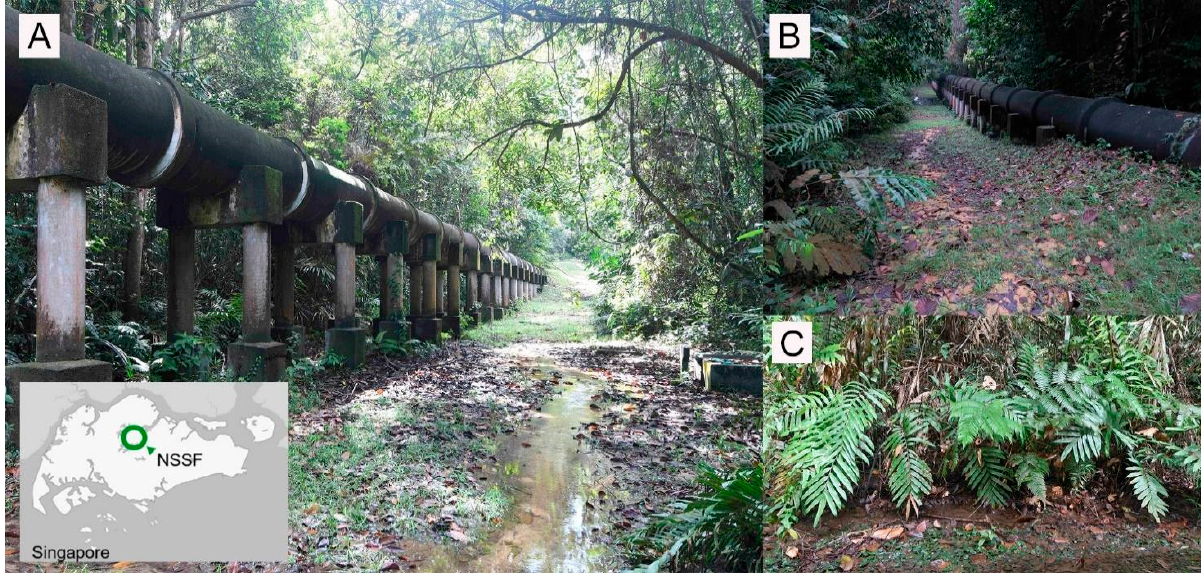
Figure 6. Habitat at Nee Soon Swamp Forest in Singapore (map, inset) where L. singapura was found; ( A , B ). The freshwater swamp is situated within the water catchment along a water supply pipeline; ( C ). Adult fireflies of L. singapura were observed flying around and/or perching among shrubs beneath the pipeline with the majority of them perched on ferns.